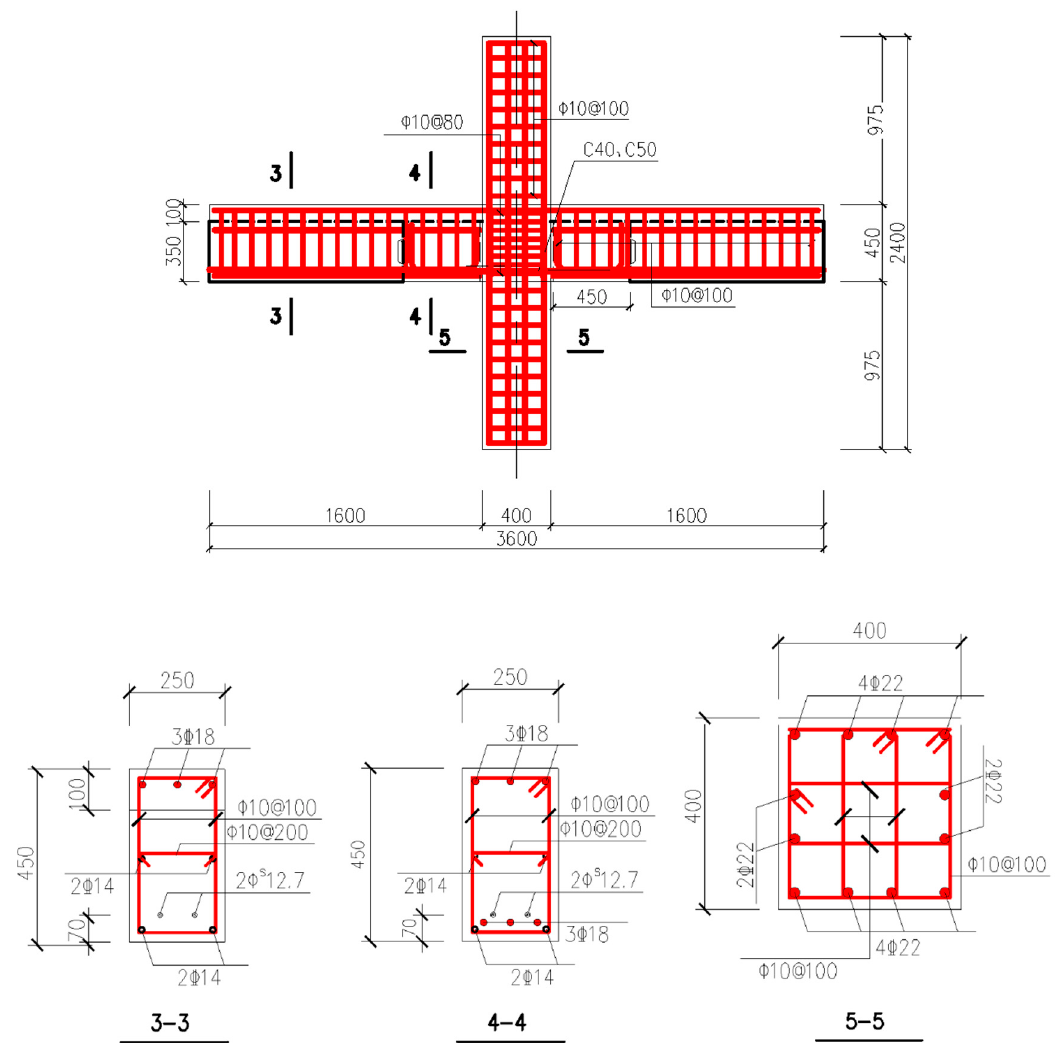
Figure 3. Reinforcement diagrams of precast prestressed concrete joints (unit: mm).